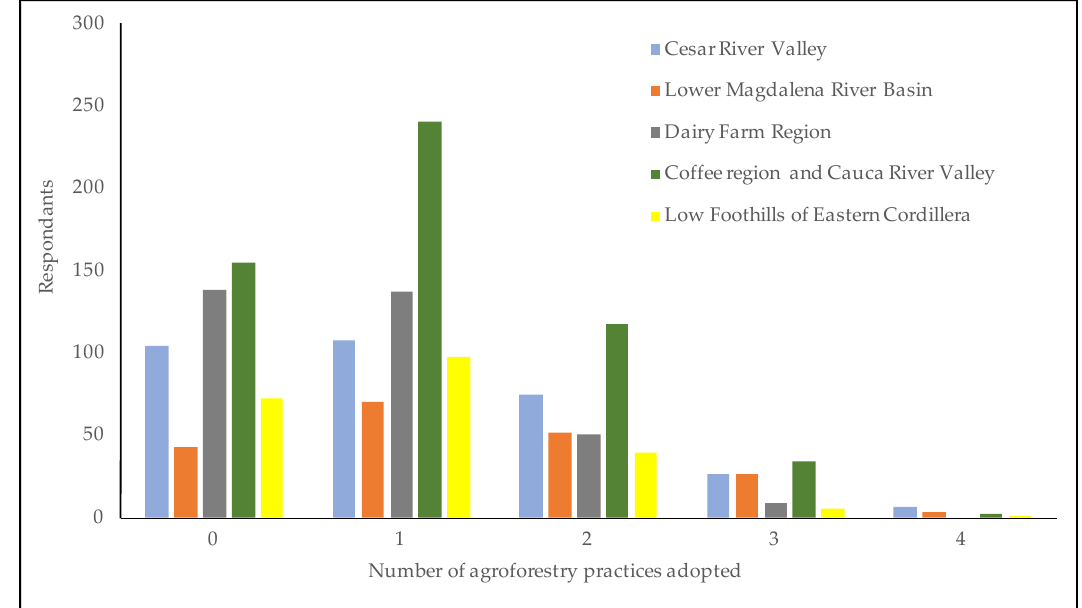
Figure 1. Number of practices adopted by eco-region.